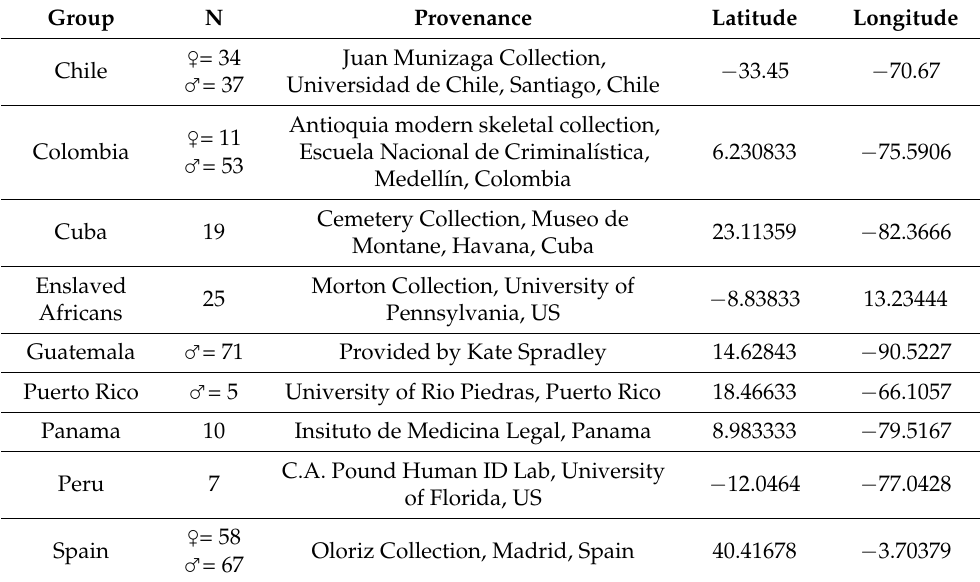
Table 1. Sample composition and provenience.